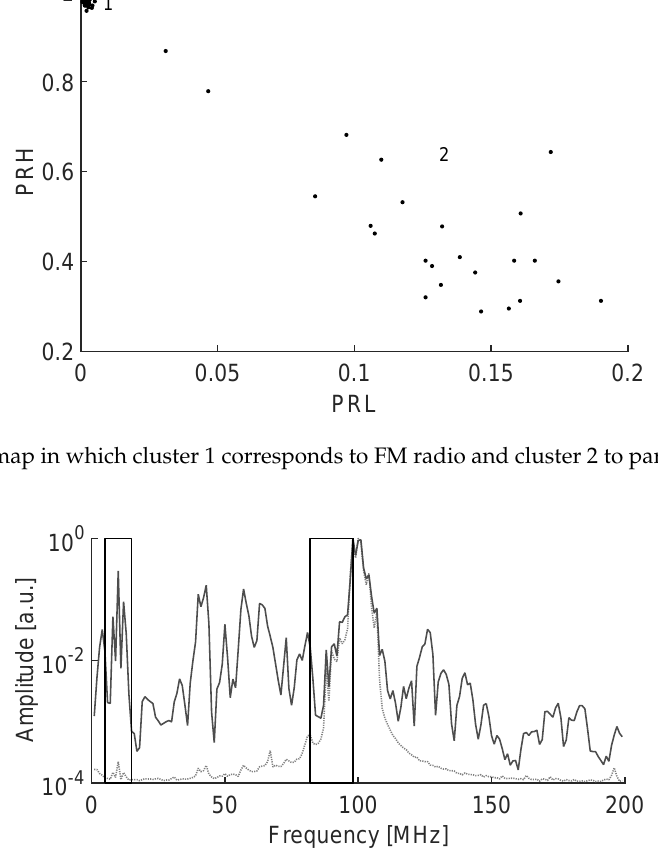
Figure 11. Average spectra of FM signals and partial discharges with the selected intervals. Notice that in this case, the vertical axis is in logarithmic scale to help in the visualization of the spectra. The dotted line corresponds to cluster 1 and the solid line to plot 2 as described in the